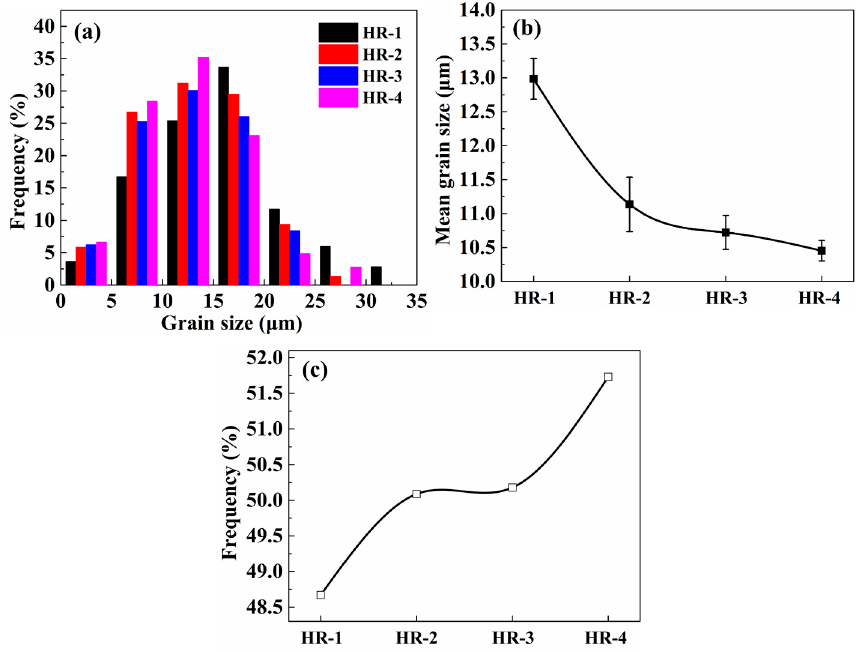
Figure 3. Statistical results of the EBSD maps: ( a ) grain distribution; ( b ) average grain size; ( c ) fre- quency of high-angle grain boundaries.